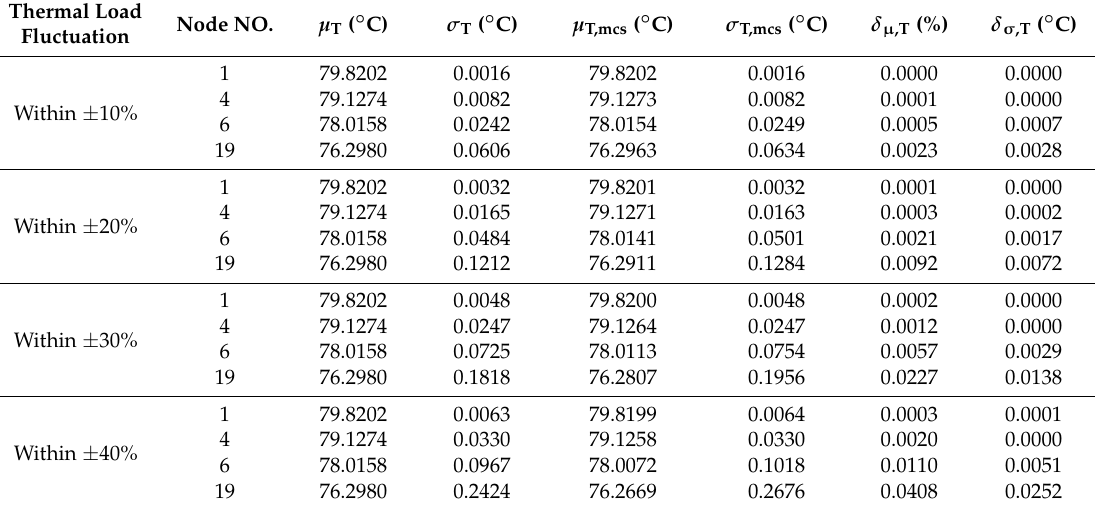
Table 6. Typical mean and standard deviations of node temperature. (Test 2: L = 1500 m; µ ϕ = 0.5